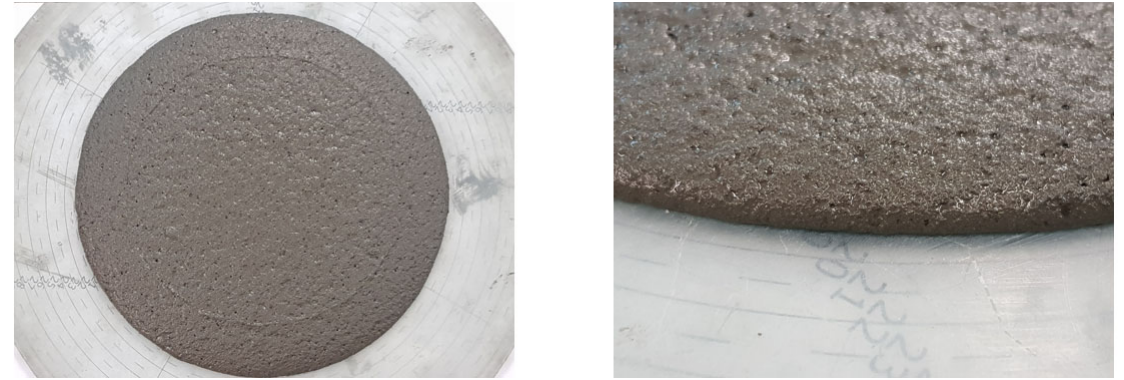
Figure 8. Evaluation of visual stability index—VSI0 for the B766/W265—PALE mix.